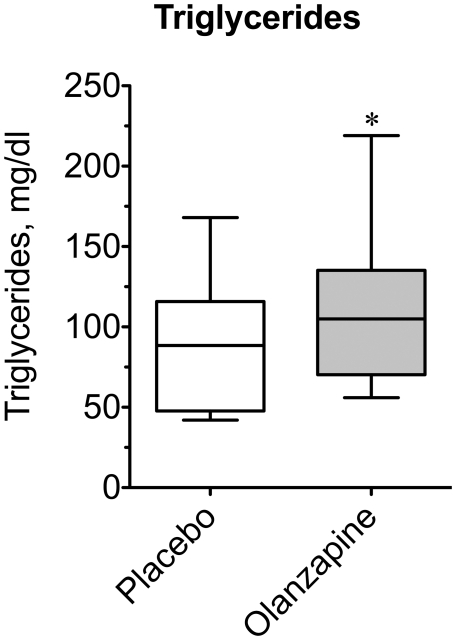
Effect of olanzapine on plasma triglycerides.For each subject baseline blood samples were drawn 10–12 h following the final dose of placebo or olanzapine tablets prior to beginning an oral glucose tolerance test for hormone and metabolite analyses. Plasma triglyceride concentration was measured for all subjects under placebo- and olanzapine-treated conditions. Data are expressed as a box plot for placebo and olanzapine-treated groups. An asterisk indicates (P = 0.017) a significant difference between the medians of the placebo and olanzapine groups (n = 15).